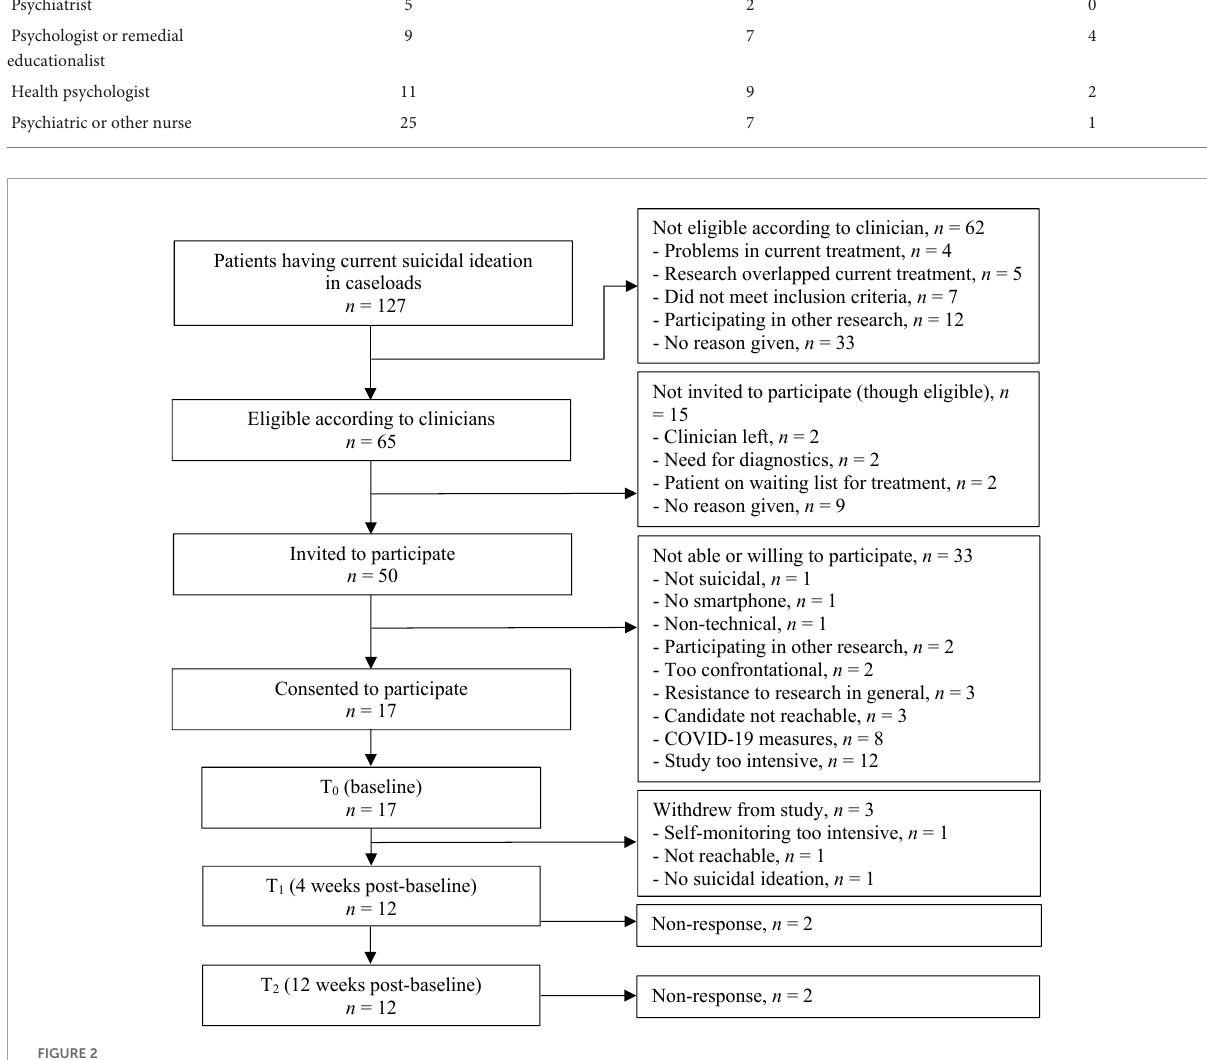
FIGURE2 Patient recruitment